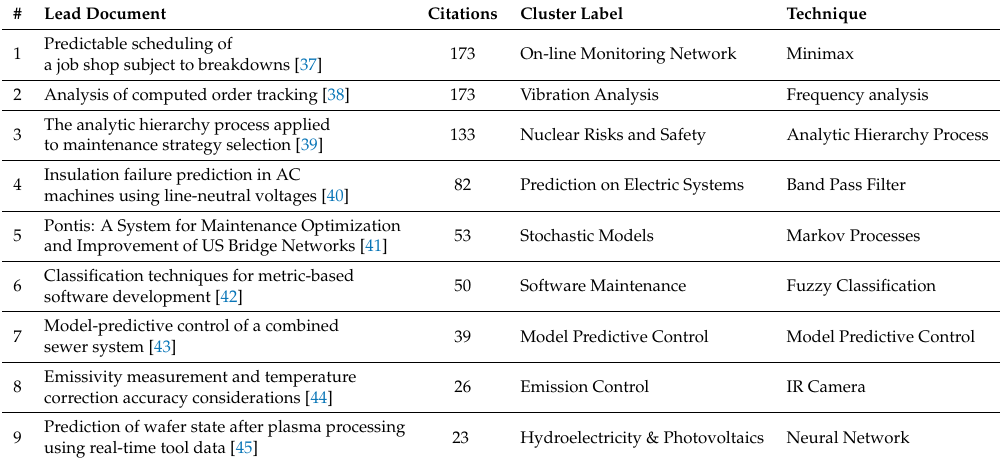
Table 3. Research Front